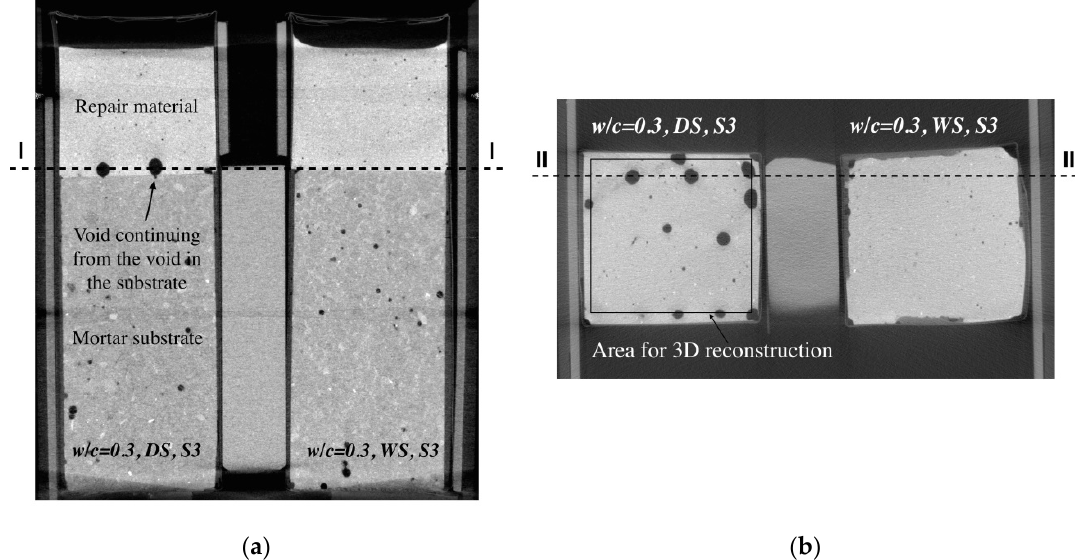
Figure 13. CT scan images for specimens w/c = 0.3, DS, S3 and w/c = 0.3, WS, S3 made at the age of 3 d: ( a ) section II ‐ II (Figure b), front view; and ( b ) section I ‐ I (Figure a), top view.